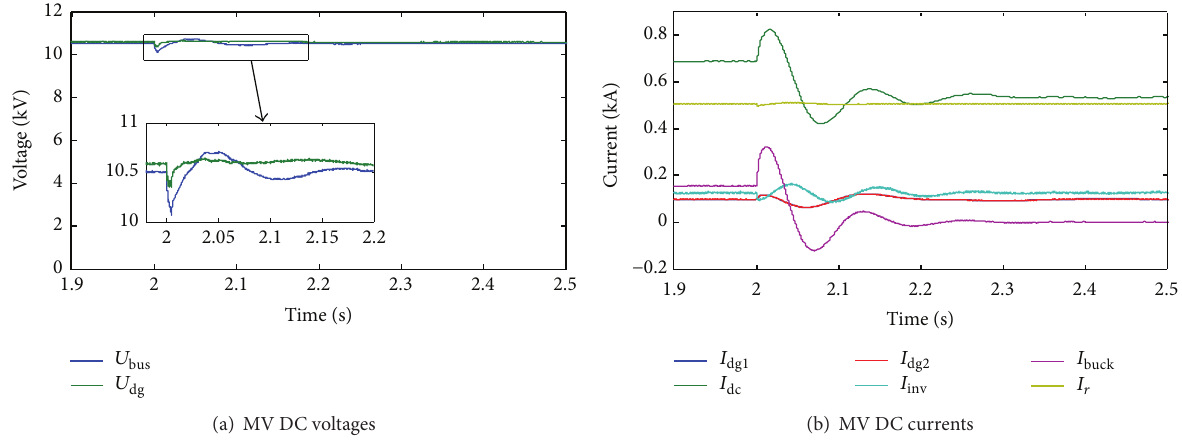
Figure 14: Transient response waveforms of fault